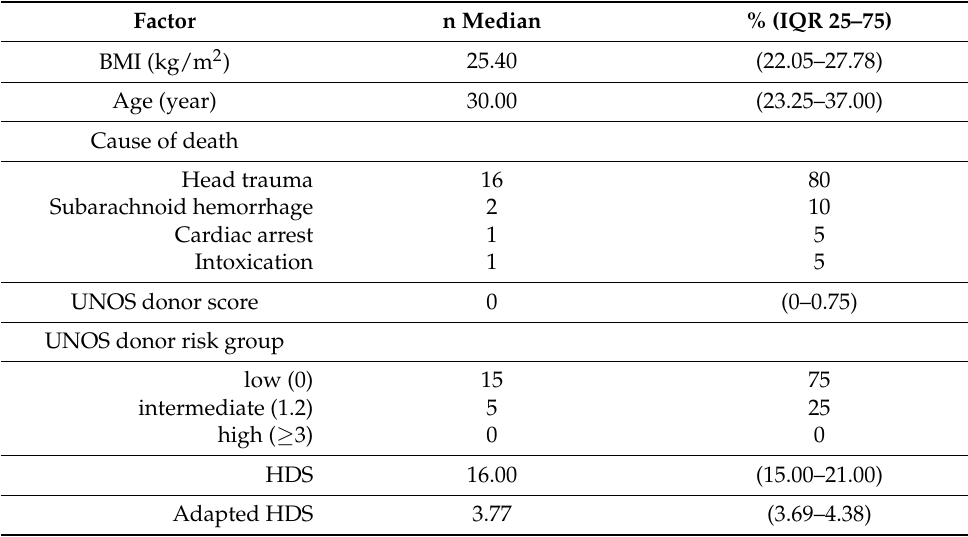
Table 1. Descriptive characteristics of the donors and heart